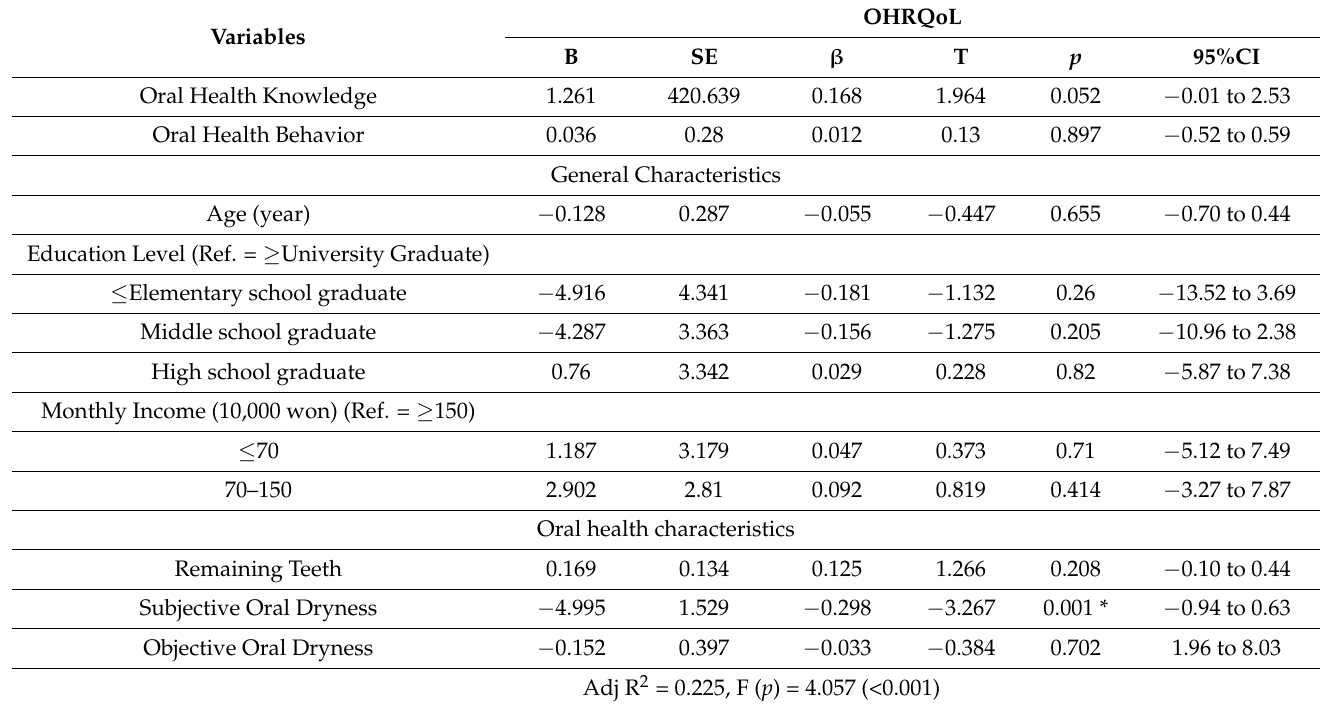
Table 3. Results of multivariate regression of factors associated with OHRQoL ( n =